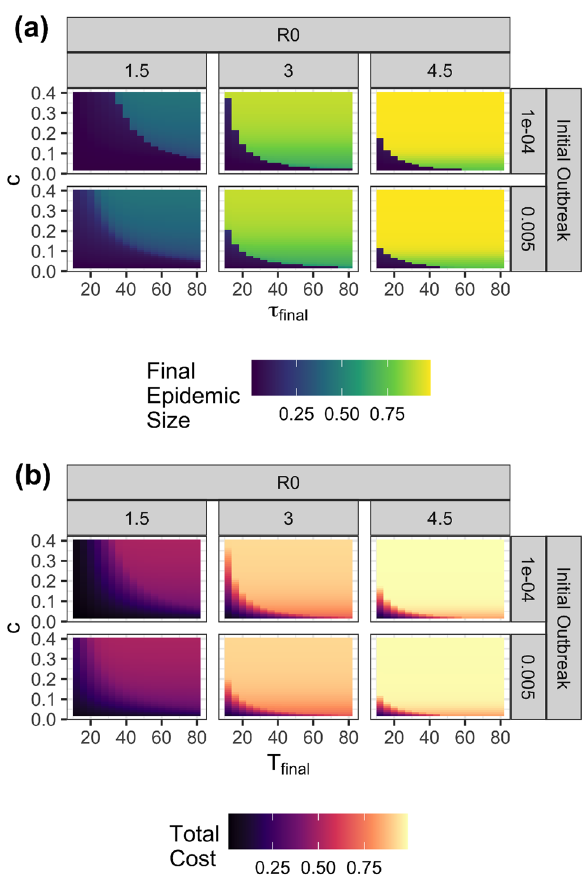
Figure 2. ( a ) Final epidemic sizes and total costs when optimal policies are followed are shown for a range of values of time horizon, τ final relative cost of social distancing c , basic reproduction number R 0 and initial outbreak of the size. ( b ) Total costs when optimal policies are followed are shown.